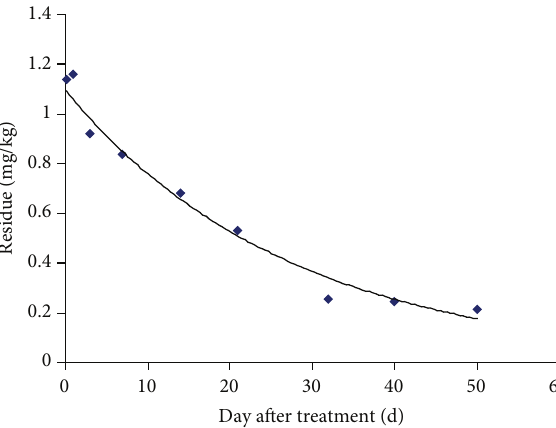
Figure 4: The dynamic dissipation rate of paclobutrazol in soil.